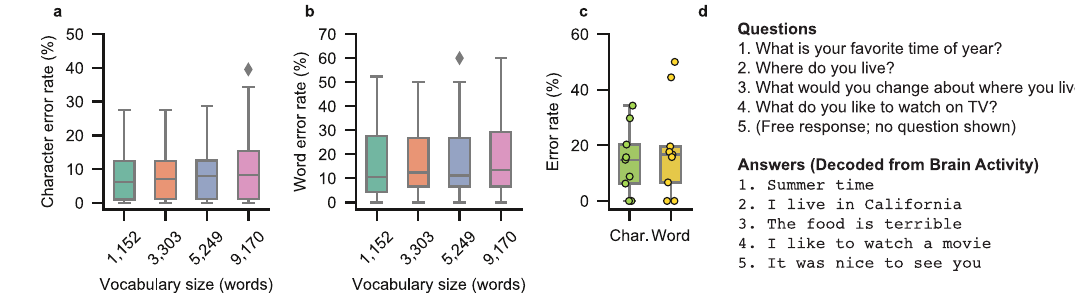
Fig. 6 | The spelling approach can generalize to larger vocabularies and con- versational settings. a Simulated character error rates from the copy-typing task withdifferentvocabularies,includingtheoriginalvocabularyusedduringreal-time decoding. b Word error rates from the corresponding simulations in a . In a and b , each boxplot corresponds to n =34 blocks (in each of these blocks, the partici- pantattemptedtospellbetweentwoto fi vesentences). c Characterandworderror rates across the volitionally chosen responses and messages decoded in real time duringtheconversationaltaskcondition.Eachboxplotcorrespondsto n =9blocks (in each of these blocks, the participant attempted to spell between two to four